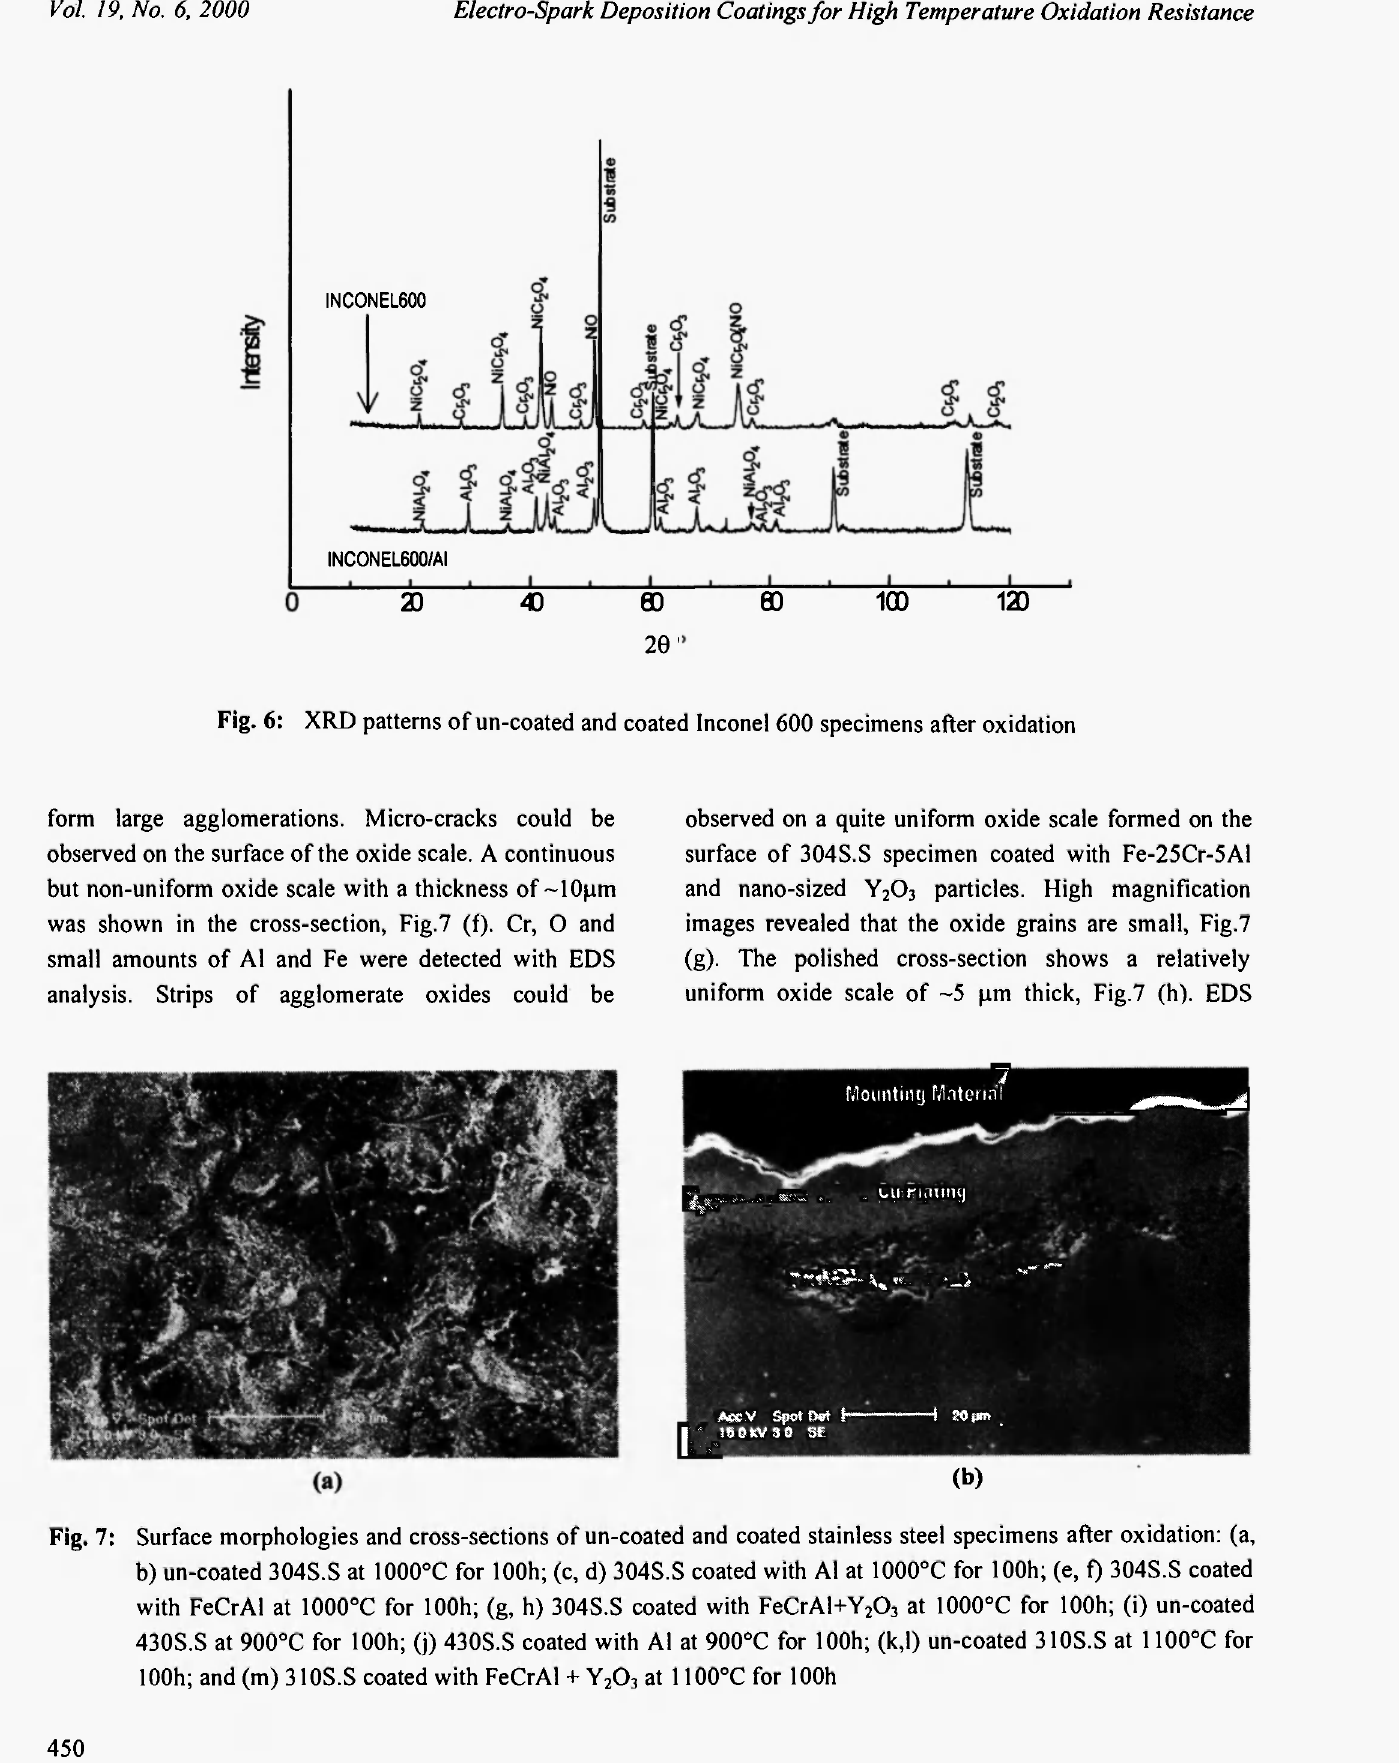
Fig. 6: XRD patterns of un-coated and coated Inconel 600 specimens after oxidation